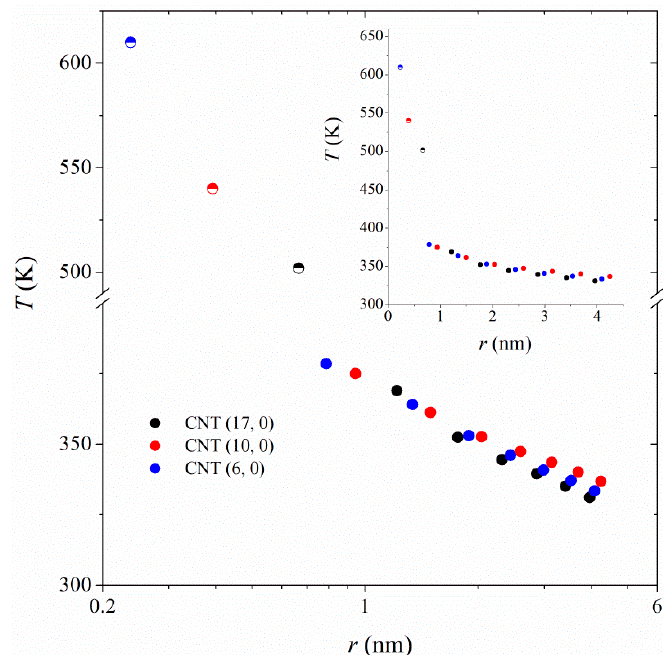
Figure 3. Radial temperature profiles for heat transfer between CNTs and PA-6,6 at 350 K and 101.3 kPa. The type of CNT is shown in the figure’s legend. The horizontal axis represents the distance from the CNT axis. The half-filled symbols represent temperatures and radii of CNTs.